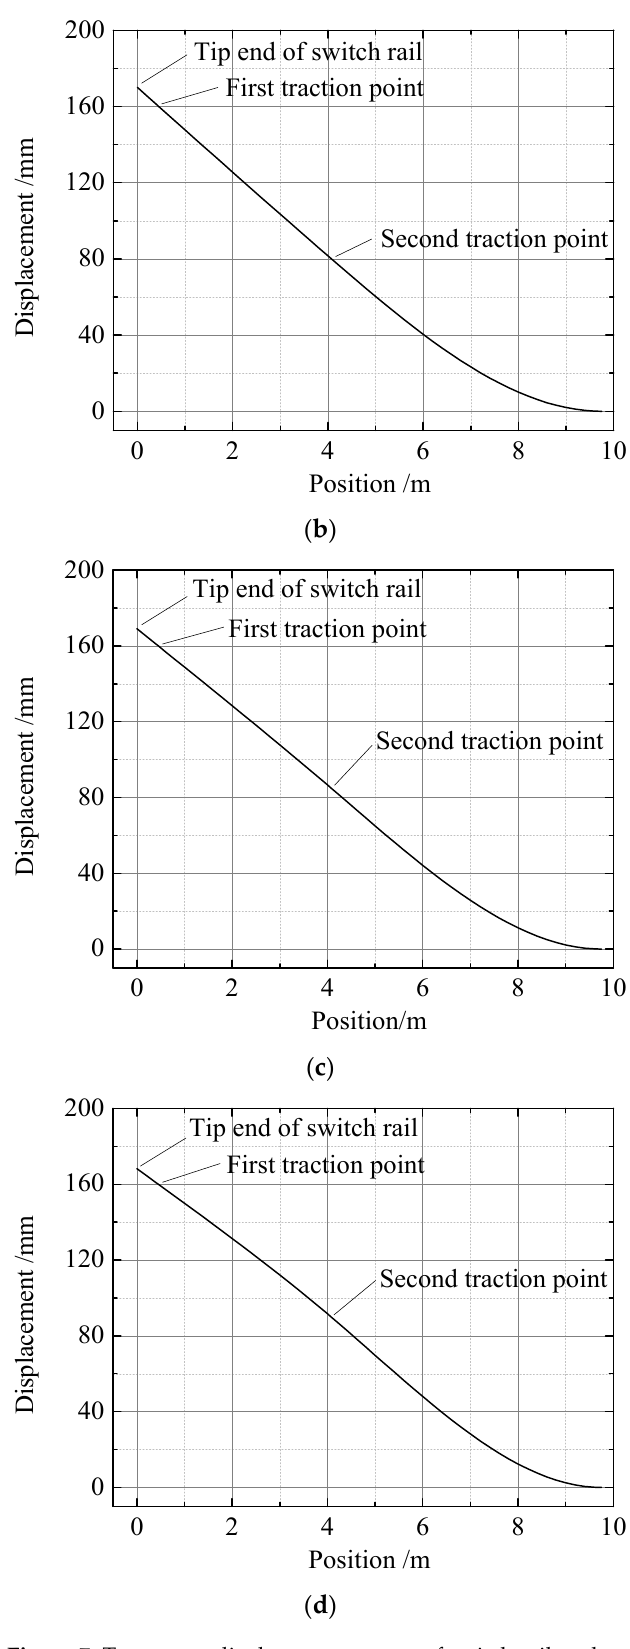
Figure 7. Transverse displacement curves of switch rail under separated state and different traction point stroke conditions. ( a ) Working condition 1, ( b ) Working condition 2, ( c ) Working condition 3, ( d ) Working condition 4.